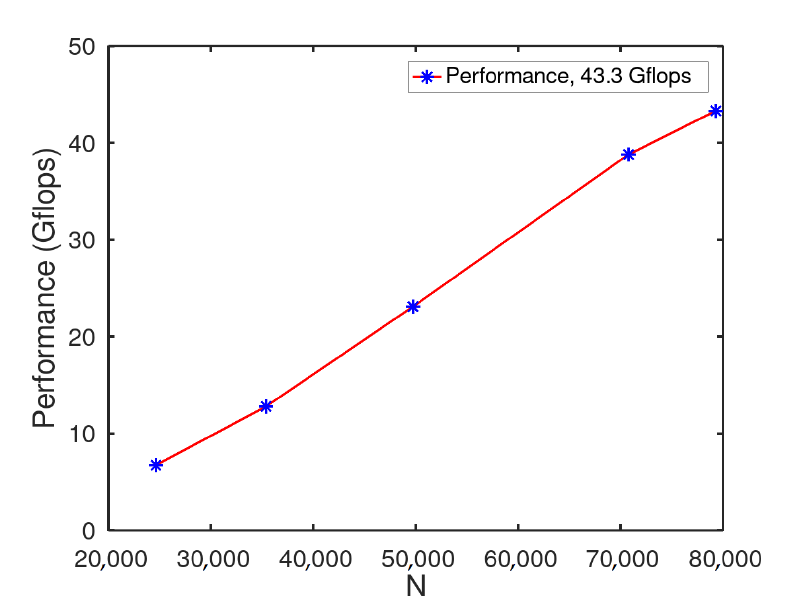
Figure 6. N vs. Gflops. HPL benchmark on ’Quinde I’ ( CPU’s only).